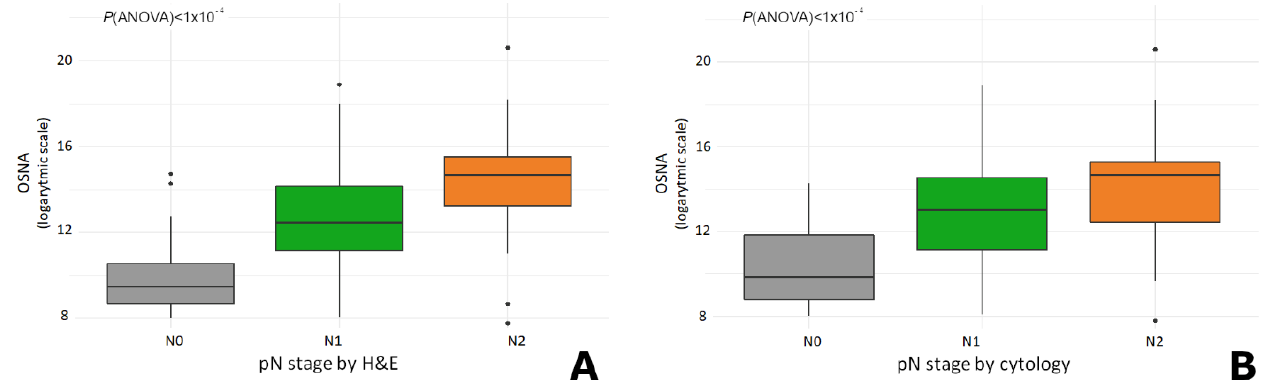
Figure 4. Total tumour load (TTL) values obtained by OSNA were correlative to the pN stages determined by ( A ) H&E and ( B ) cytology-based analysis. p -values were determined using an ANOVA test. Tumours with OSNA >300,000 (superior outlier values) were excluded from both graphs to enable a better visualization between groups. H&E: haematoxylin and eosin; OSNA: one-step nucleic acid amplification.